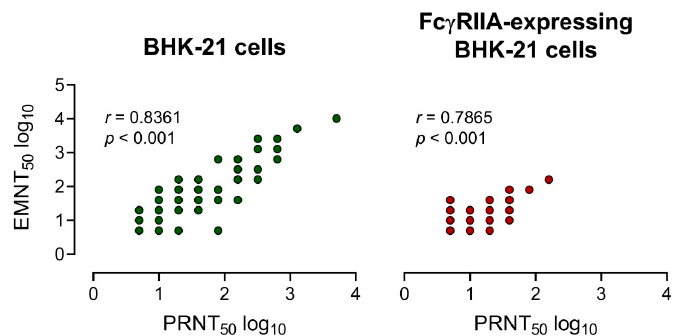
Figure 3. Correlation of neutralizing titers measured by EMNT vs PRNT. Correlation of the neutralizing titers of 25 serum samples (12 DENV IgG + and 13 ZIKV IgG + sera) and 3 anti-E mouse monoclonal antibodies determined by EMNT and PRNT using BHK-21 and Fc γ RIIA-expressing BHK-21 as assay cells. Neutralizing titers were expressed in log